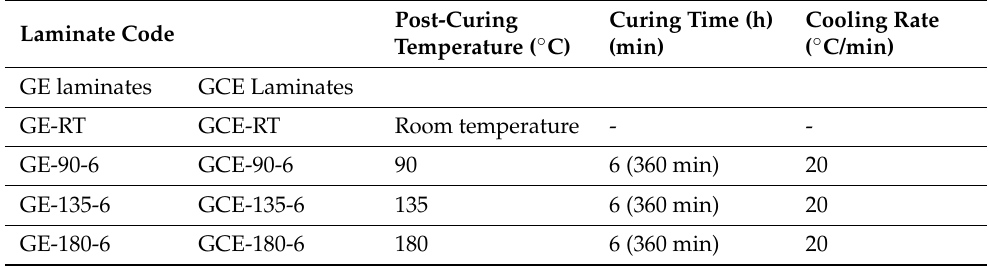
Table 1. Laminate Codes for GE and GCE laminates based on post-curing